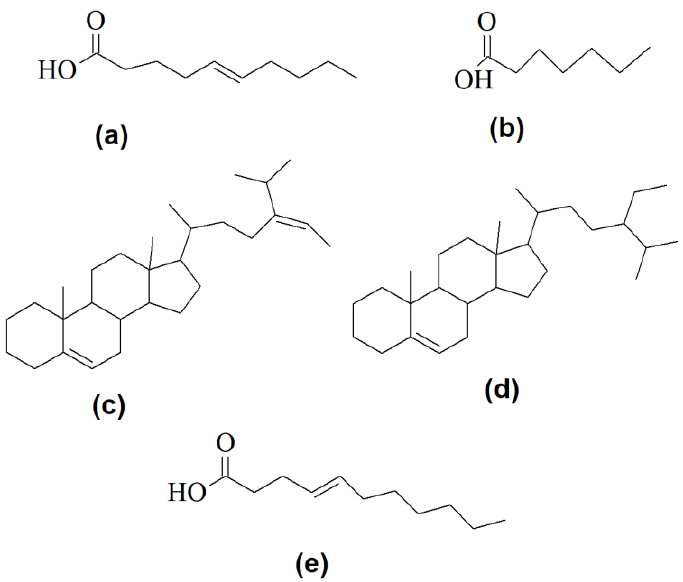
Figure 5. Chemical structures of some selected bacterial and microalgal compounds screened by computer-aided drug design, demonstrating their relevance in vitro and promising further testing. ( a )